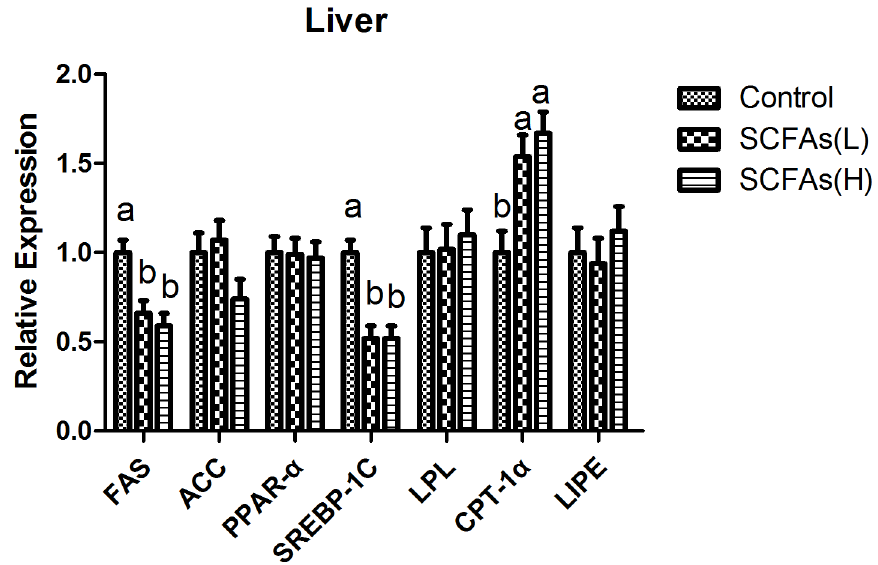
Fig 1. Effects of SCFAs on mRNA expressions for key factors related to lipid metabolism in liver over the experimental period of weaned pigs. SCFAs (L): acetic acid 20.04 mM, propionic acid 7.71 mM and butyric acid 4.89 mM; SCFAs (H) :acetic acid 40.08 mM, propionic acid 15.42 mM and butyric acid 9.78 mM. FAS fatty acid synthase; ACC acetyl-CoA carboxylase; PPAR peroxisome proliferator activated receptor; SREBP-1C sterol regulatory element binding protein 1C; LPL lipoprotein lipase; CPT-1 α carnitine palmitoyltransferase-1 α ; LIPE lipase hormone- sensitive. a-b Within a row, means without a common superscript differ (P < 0.05).